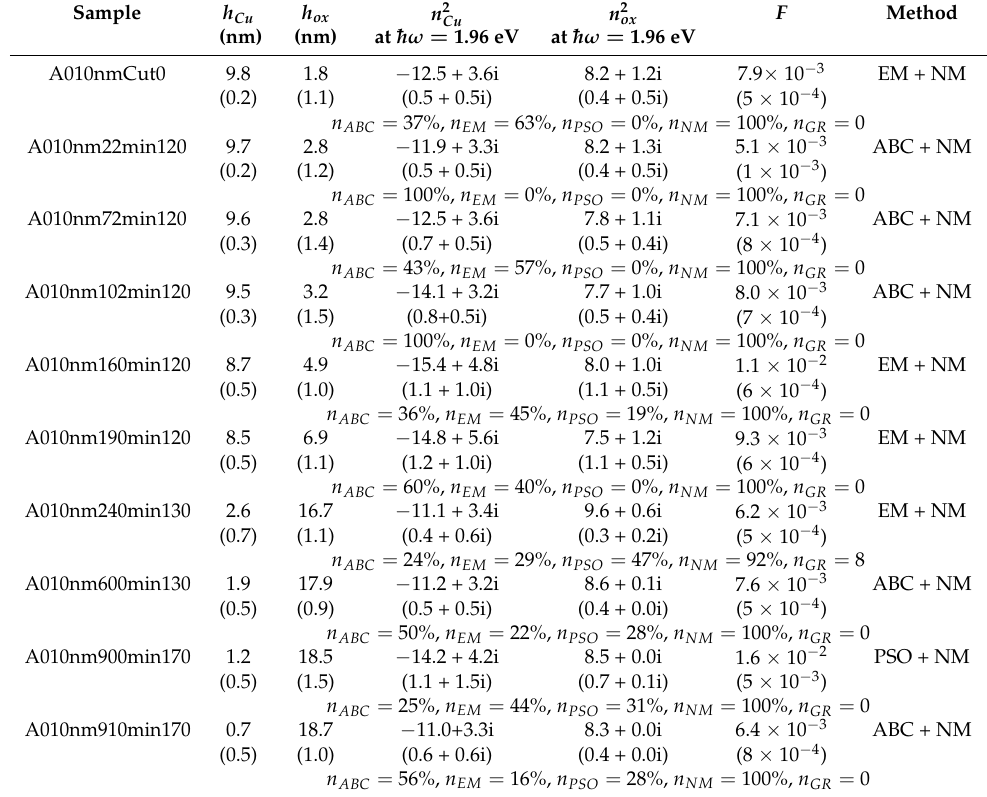
Table A3. The recovered thickness of copper and copper oxide, and the relative permittivity of copper and copper oxide at λ 0 = 632.8 nm, by fitting experimental UV-visible-NIR absorbance curves. The value of the multi-objective function F (Equation (A3)) and the most efficient metaheuristics are also indicated. Values between brackets are standard deviations for acceptable solutions, i.e., obtained for F below a 25% threshold (for F ∈ [ min ( F ) ;1.25 × min ( F )] . The corresponding success of each metaheuristic is indicated in